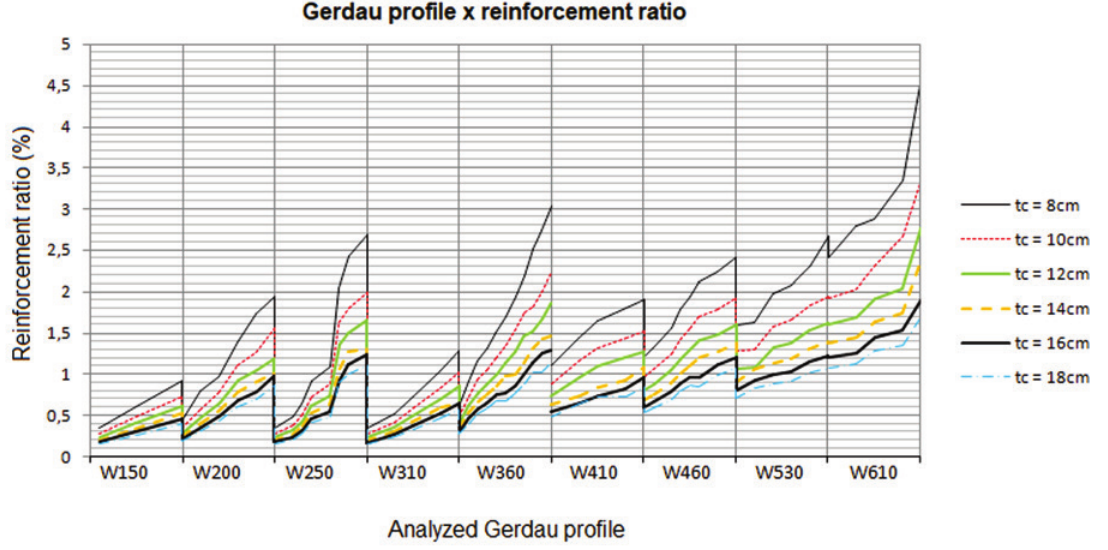
Reinforcement ratio as function of the analyzed profile, for the semi-continuous case fire resistance time (for 0.7 load